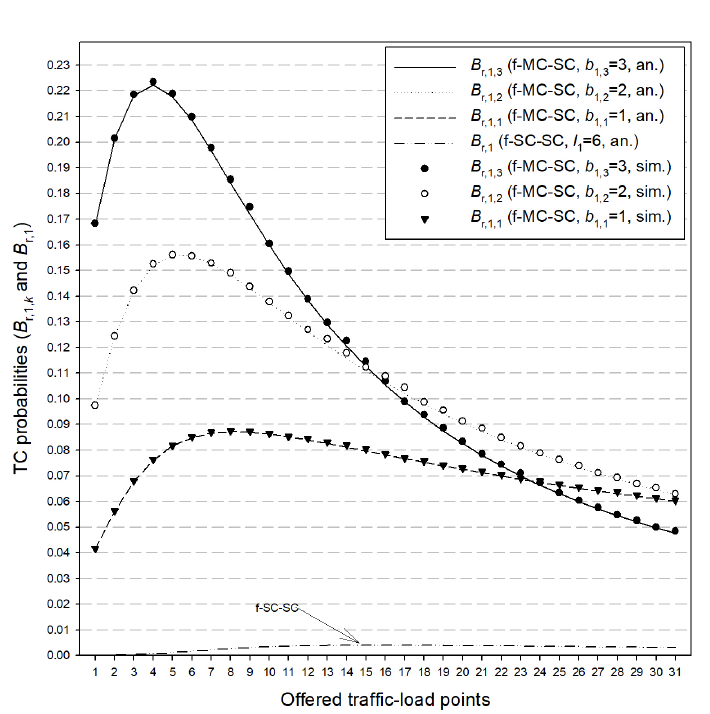
Figure 4. TC probabilities due to RRUs unavailability (1st